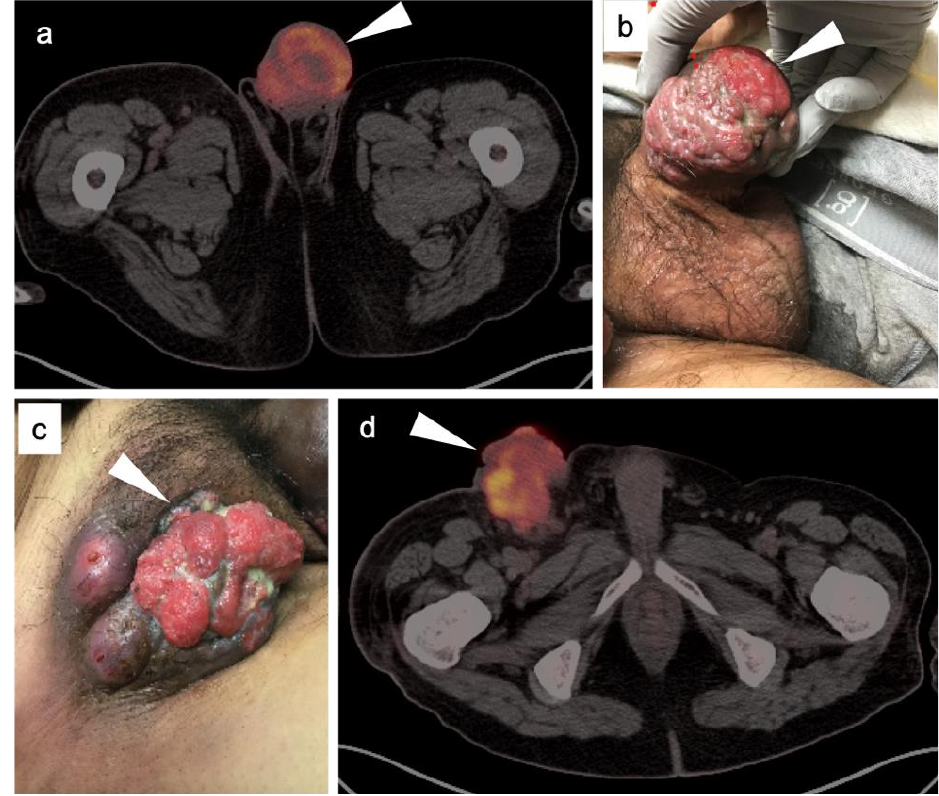
Figure 53. Large squamous cell carcinoma of the penis with fungating right inguinal lymph node shown on FDG PET-CT. ( a ) Axial FDG PET-CT image shows very large penile hypermetabolic mass (white arrowhead). ( b ) Photograph of the tumor shows large lobular, erythematous mass involving the glans penis (white arrowhead) extending into the penile shaft. ( c ) Photograph of the right inguinal lymph node shows a large, fungating, ulcerated right inguinal nodal mass that has extended through the skin (white arrowhead). ( d ) Axial FDG PET-CT of the right inguinal lymph node mass shows a large, lobular hypermetabolic mass in the right inguinal